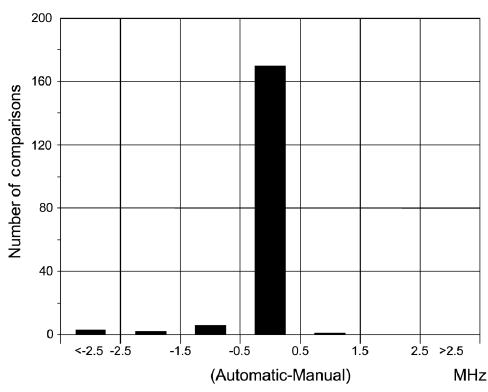
Fig. 2. Differences between the values of MUF(3000) F 2 scaled by Autoscala and by the stan- dard manual method considering ionograms for which the operator was able to scale only the MUF(3000) F 2 (subset B ). Out of 182 cases it re- sults: for 170 cases ( − 0.5 MHz ≤δ≤ 0.5 MHz); for 1 case (0.5 MHz <δ≤ 1.5 MHz); for 6 cases ( − 1.5 MHz ≤δ<− 0.5 MHz); for 0 cases (1.5 MHz <δ≤ 2.5